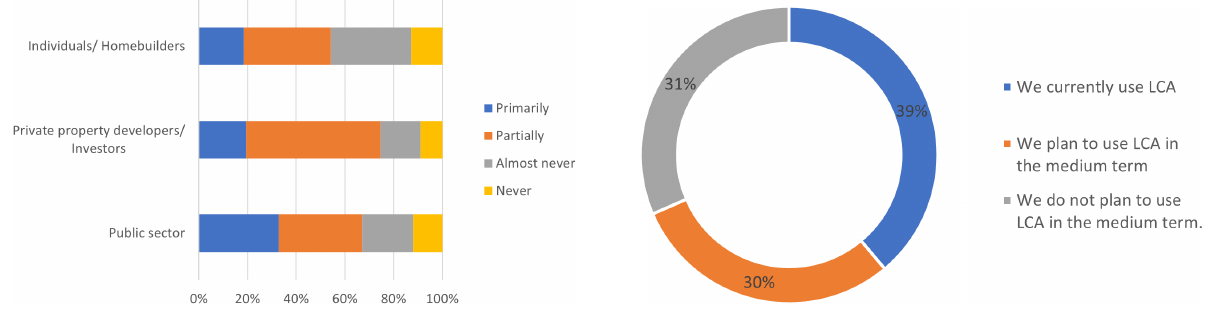
Figure 6. Type of clients that demand services with regard to environmental performance (based on 67 responses) .